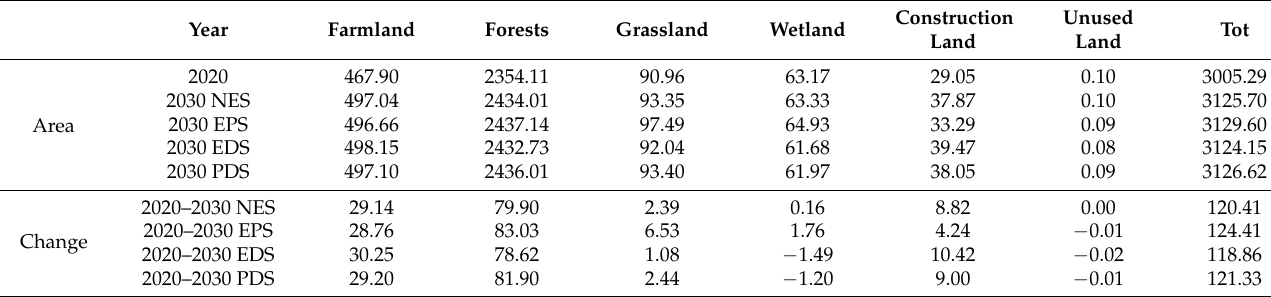
Table 4. CS in DLB from 2020 to 2030 (unit: